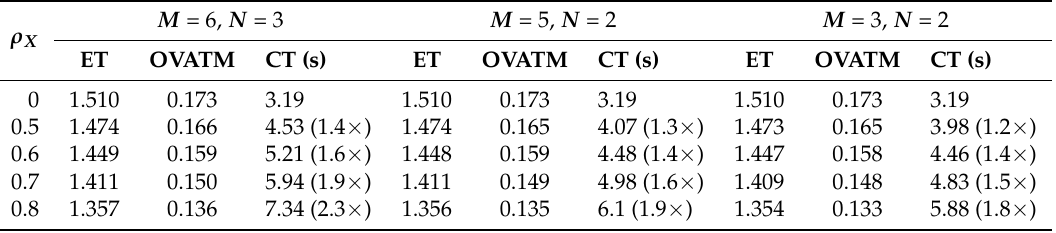
Table 1. Exercise thresholds (ET), option values at the money (OVATM), calculation times (backwards induction step) (CT), for multiple simulations of the process. The centre columns correspond to Figure 3b ( ρ X = 0), and Figure 4a–d ( ρ X = 0.5,0.6,0.7,0.8, respectively). The other columns were generated through changing only the values of M , N as indicated. Figures in parentheses represent calculation times as a multiple of the ρ X = 0